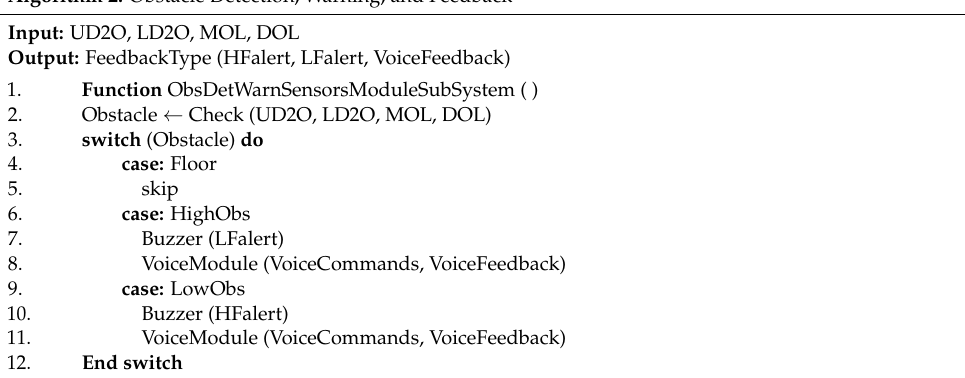
Algorithm 2: Obstacle Detection, Warning, and